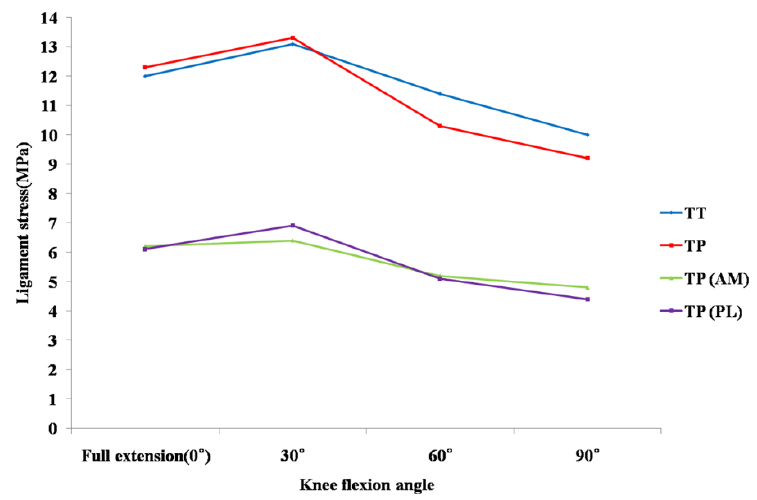
Figure 5. Comparison of graft stress under a 134 N anterior load between conventional single- bundle and anatomical double-bundle anterior cruciate ligament reconstruction. Abbreviations: TT, transtibial; TP, transportal; AM, anteromedial; PL, posterolateral.